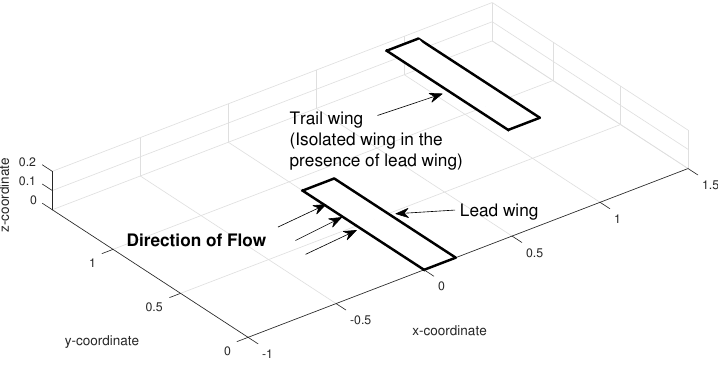
Figure 8. Schematic of two NACA23012 wings in tandem